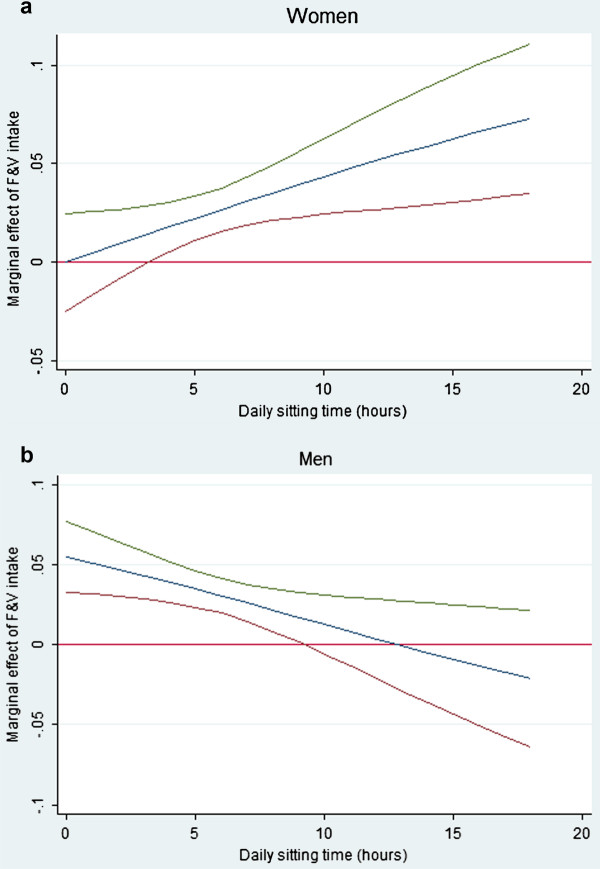
Interaction effectawith LTPA held at mean, with 95% confidence intervals (CIs), women. Note a Change in probability of rating health as good or better for one unit change in F&V intake at different values of ST.